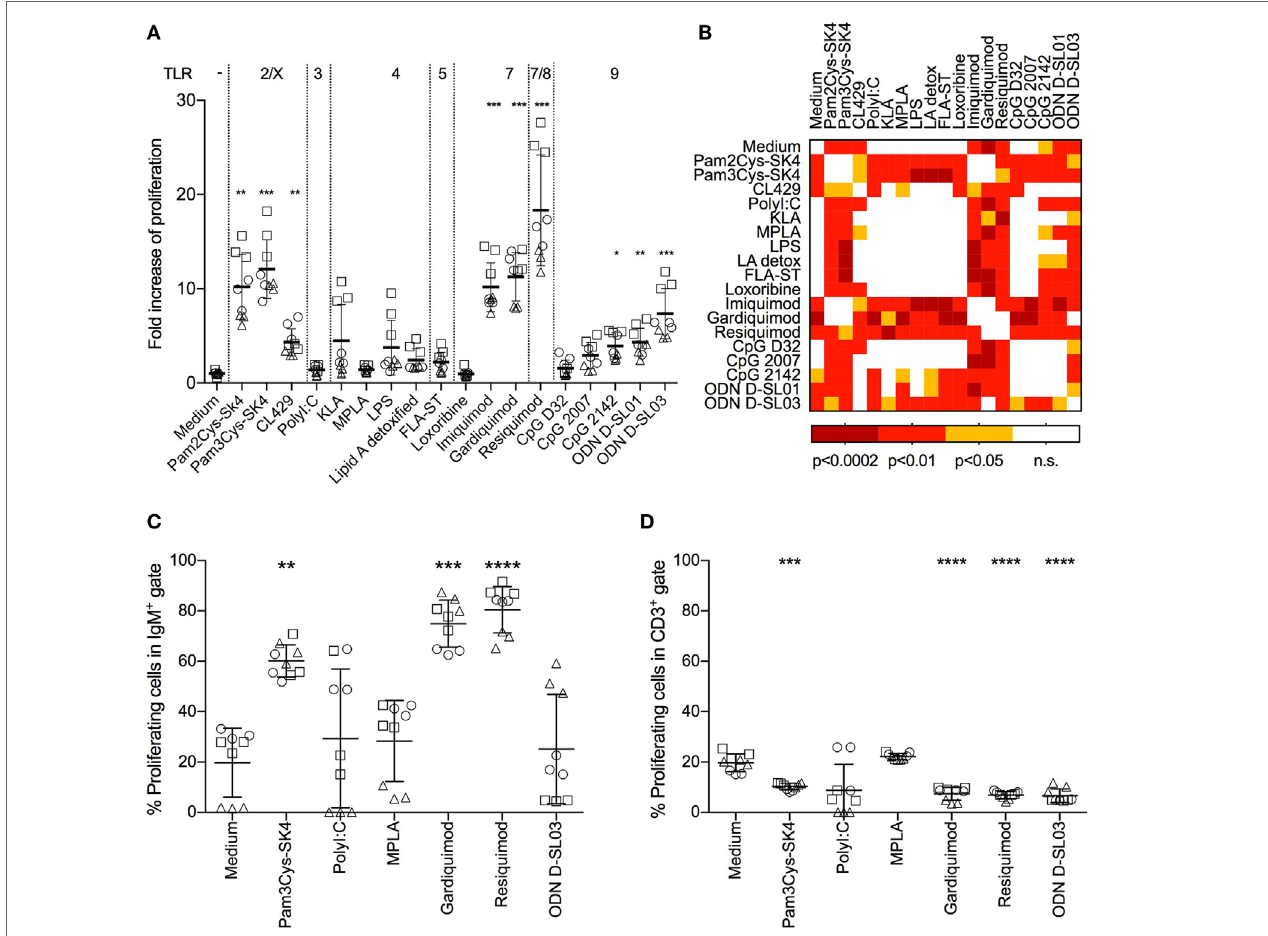
FigUre 1 | Proliferative response of B cells in whole peripheral blood mononuclear cells (PBMCs) after stimulation with toll-like receptor ligands. (a) Proliferation of PBMCs after stimulation for 3 days was determined using a 3 H-thymidine assay. The fold increase over the medium control is shown. (B) Heatmap giving an overview of the statistical significances found between the treatments shown in (a) . (c) Proliferation of IgM + B cells determined by flow cytometry using CellTraceViolet. The percentage of proliferating cells in the IgM gate is shown. (D) Proliferating CD3 + T cells, again determined using CellTrace Violet. The percentage of proliferating cells in the CD3 gate is shown. (a,c,D) PBMC culture triplicates from three different animals, each depicted by a different shape. Mean values are indicated by horizontal bars. Error bars show SDs. Statistical significance was calculated using ANOVA followed by Tukey’s test (**** P < 0.0001; *** P < 0.001; ** P < 0.01; * P < 0.05; n.s., not